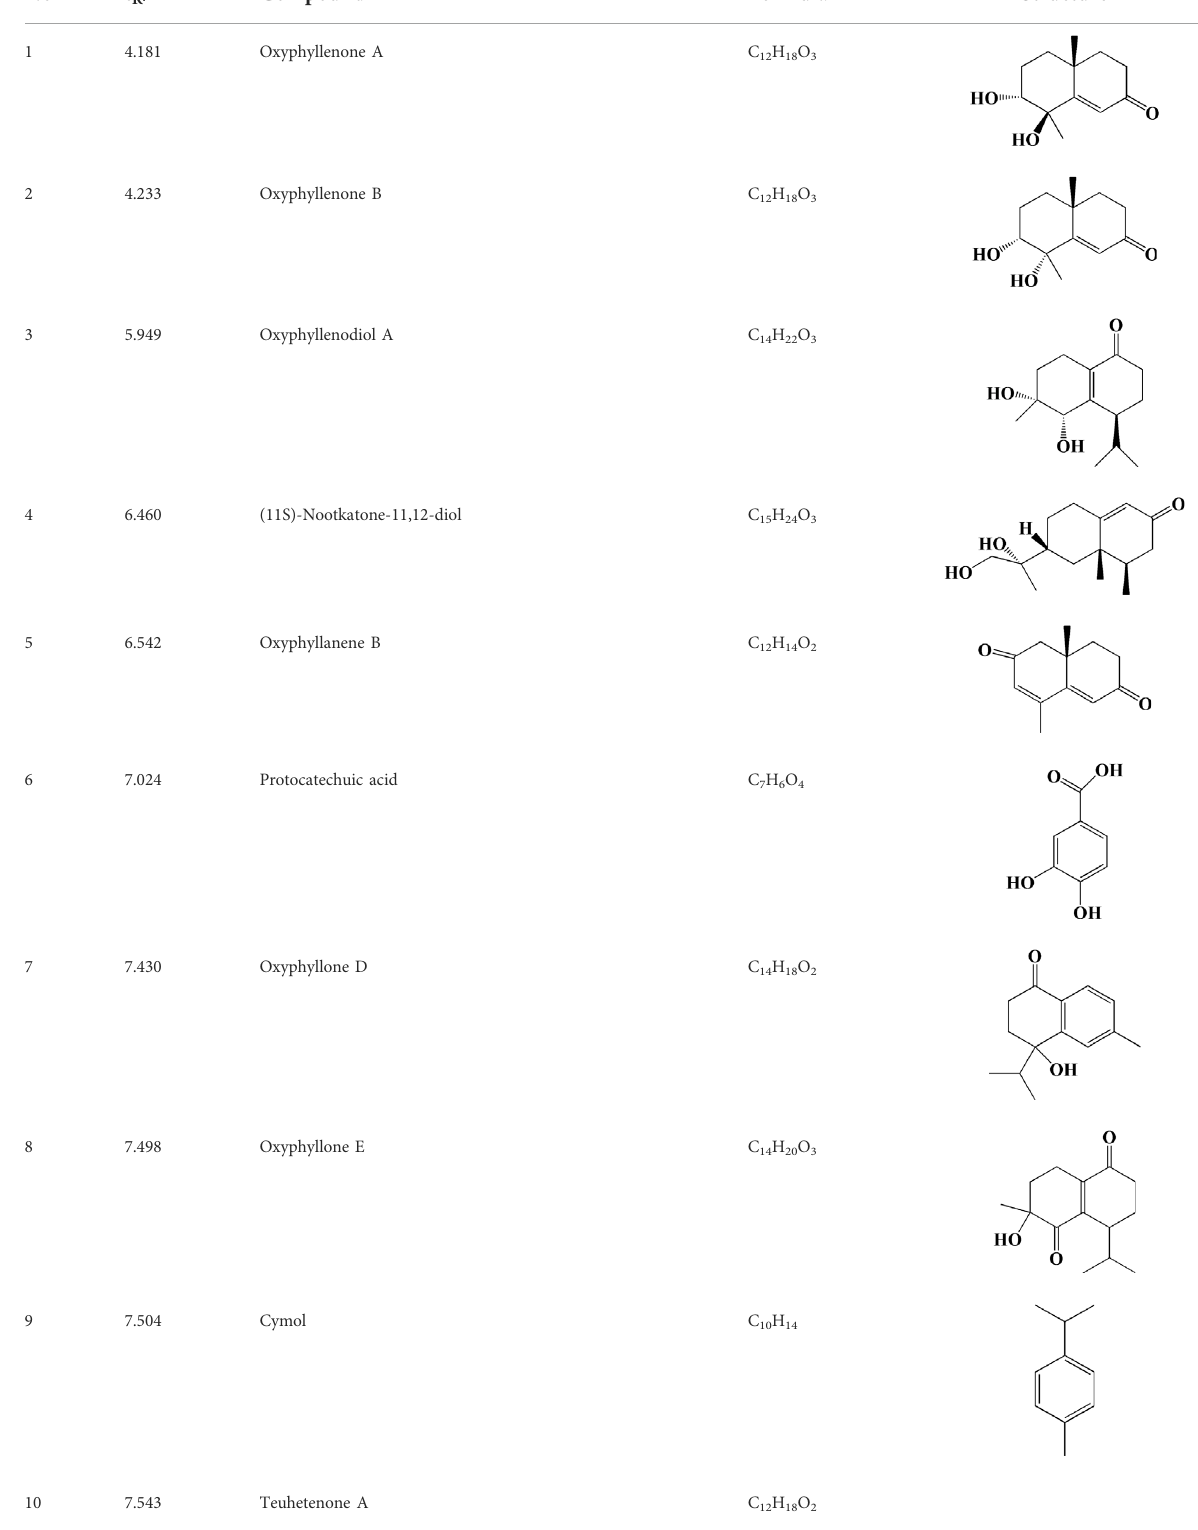
TABLE 1 Identi fi ed constituents of Alpiniae oxyphyllae Fructus by LC-MS. No t /min Compound Formula R